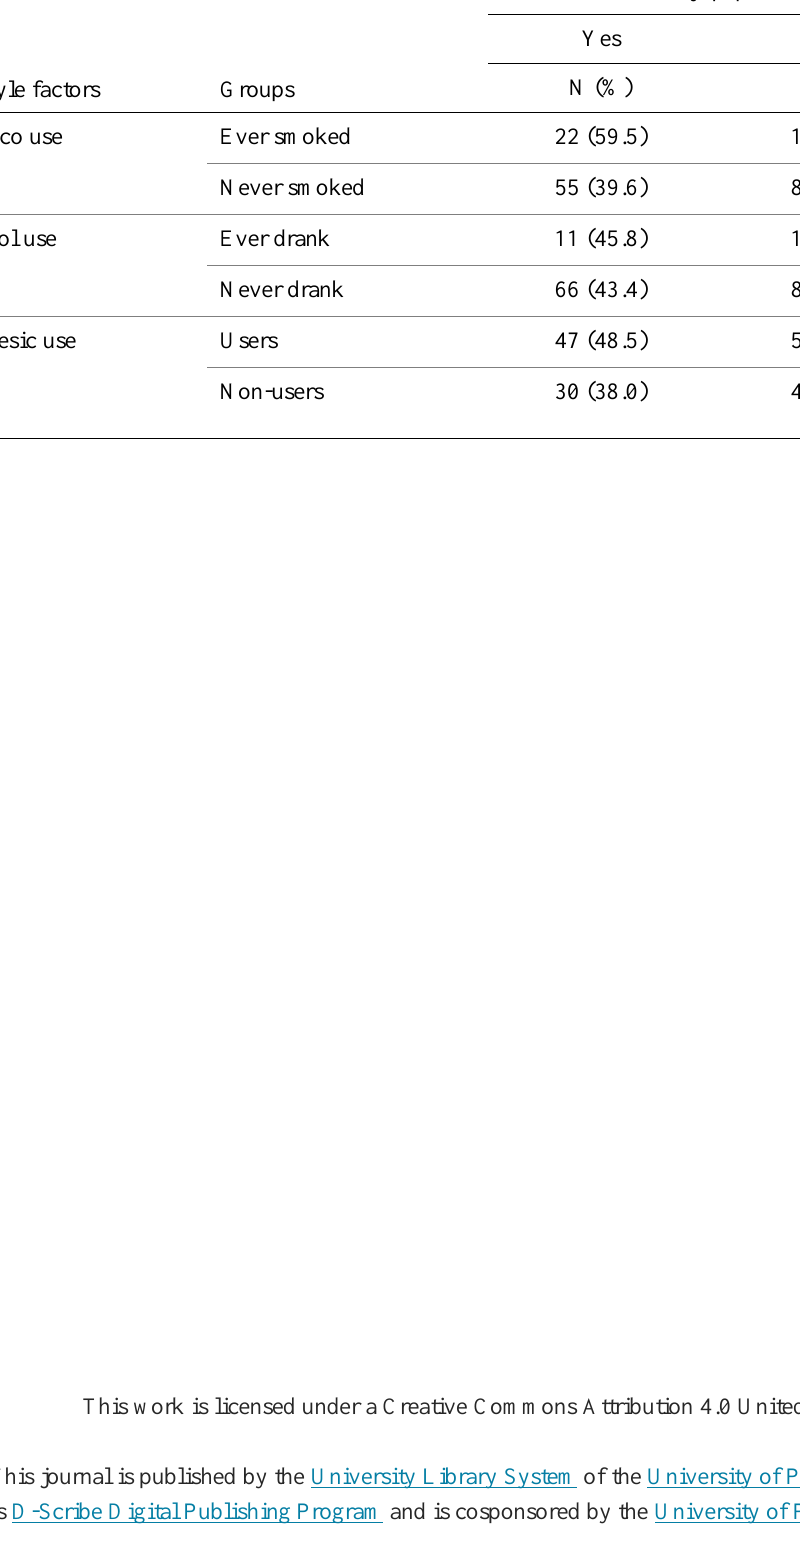
Lifestyle factors Groups Tobacco